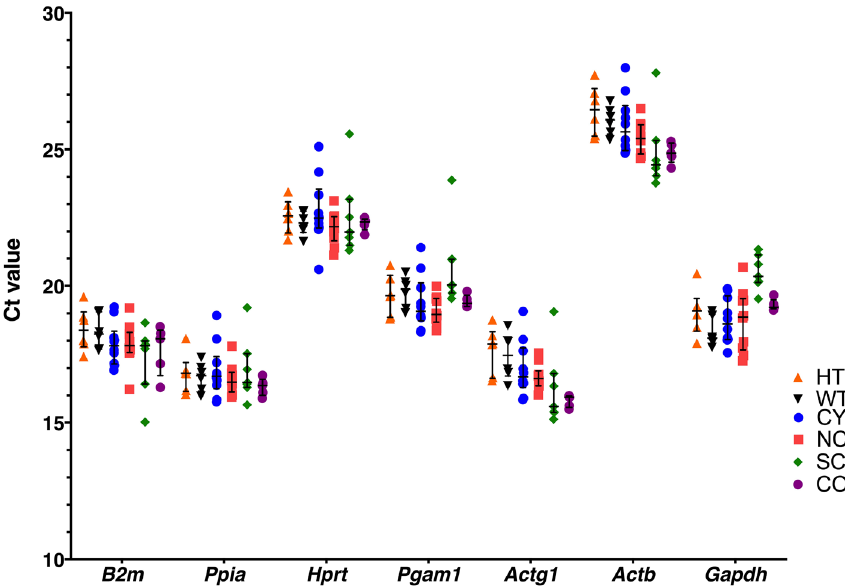
Figure 2. Renal expression profiles of the seven selected candidate housekeeping genes in Pkd1 -deficient mouse models. Lower threshold values (Ct) indicate higher expression levels. The median values are expressed as horizontal lines while the error bars represent the corresponding interquartile ranges. The Actb Ct values were the highest ones, reflecting the lowest expression levels whereas the Actg1 Ct values were the lowest, indicating the highest